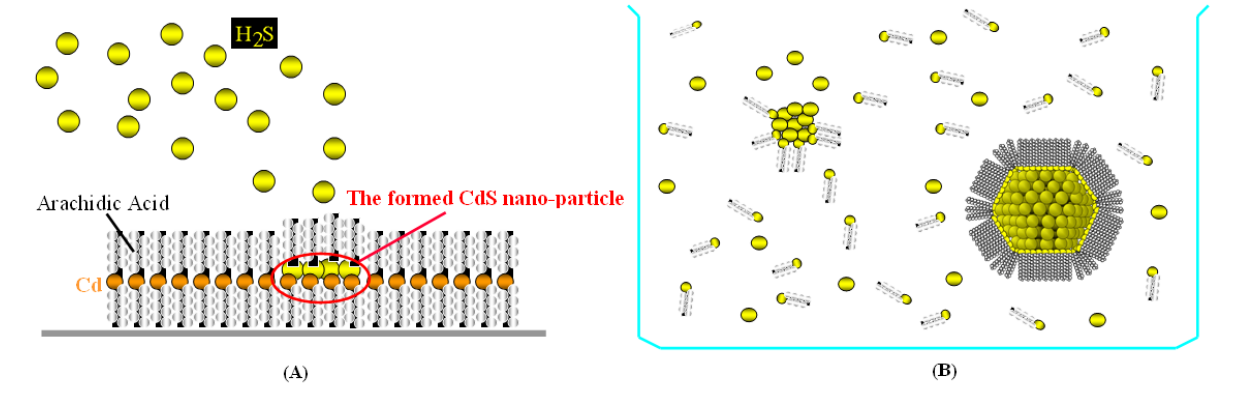
Figure 7. (A) Schematic model describing the role of hydrogen sulfide (H semi-conducting nano-particles inside a Langmuir-Blodgett mono-layer made of arachidic acid. (B) Schematic model describing the role of alkanethiols in stabilizing metallic nano-particles in a solution which contains gold salts (HAuCl